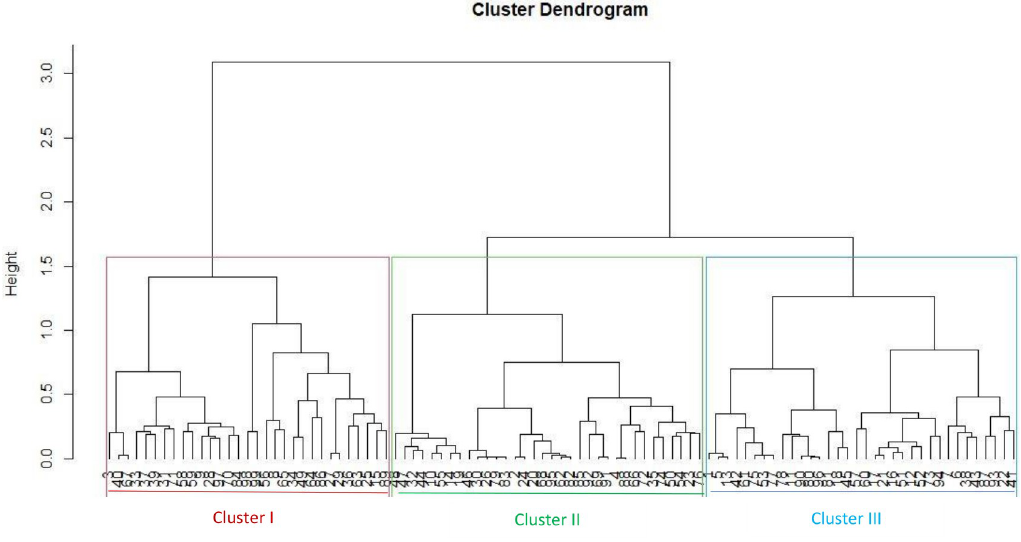
Fig 5. Dendrogram showing relatedness among the 99 groundnut genotypes based on genotypic matrix.